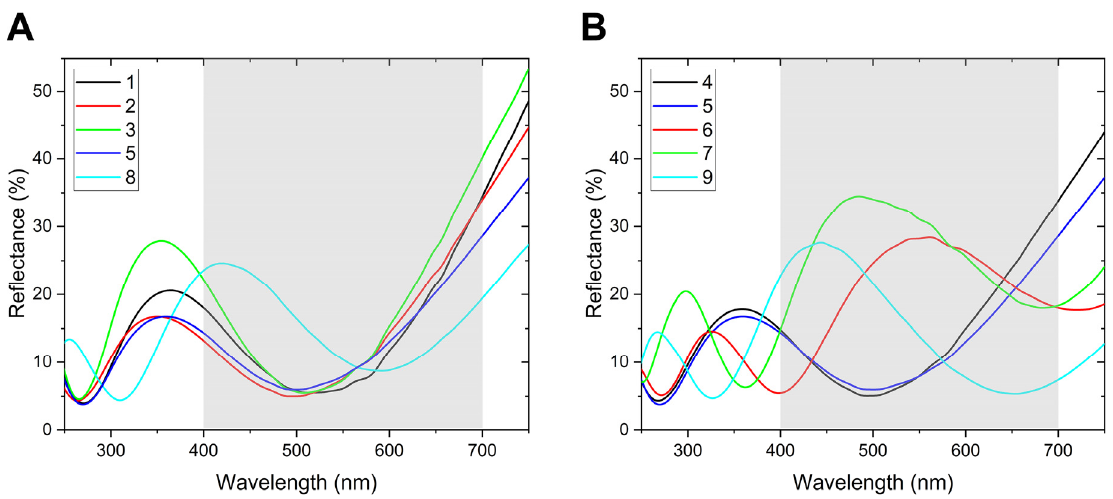
Figure 5. Reflectance spectra of the investigated Euphaedra neophron specimens (for working numbers, see Table 2). ( A ) 1, 2, 3, 5: E. n. violaceae males, 8: female. ( B ) 4: E. n. ellenbecki , 5: E. n. violaceae